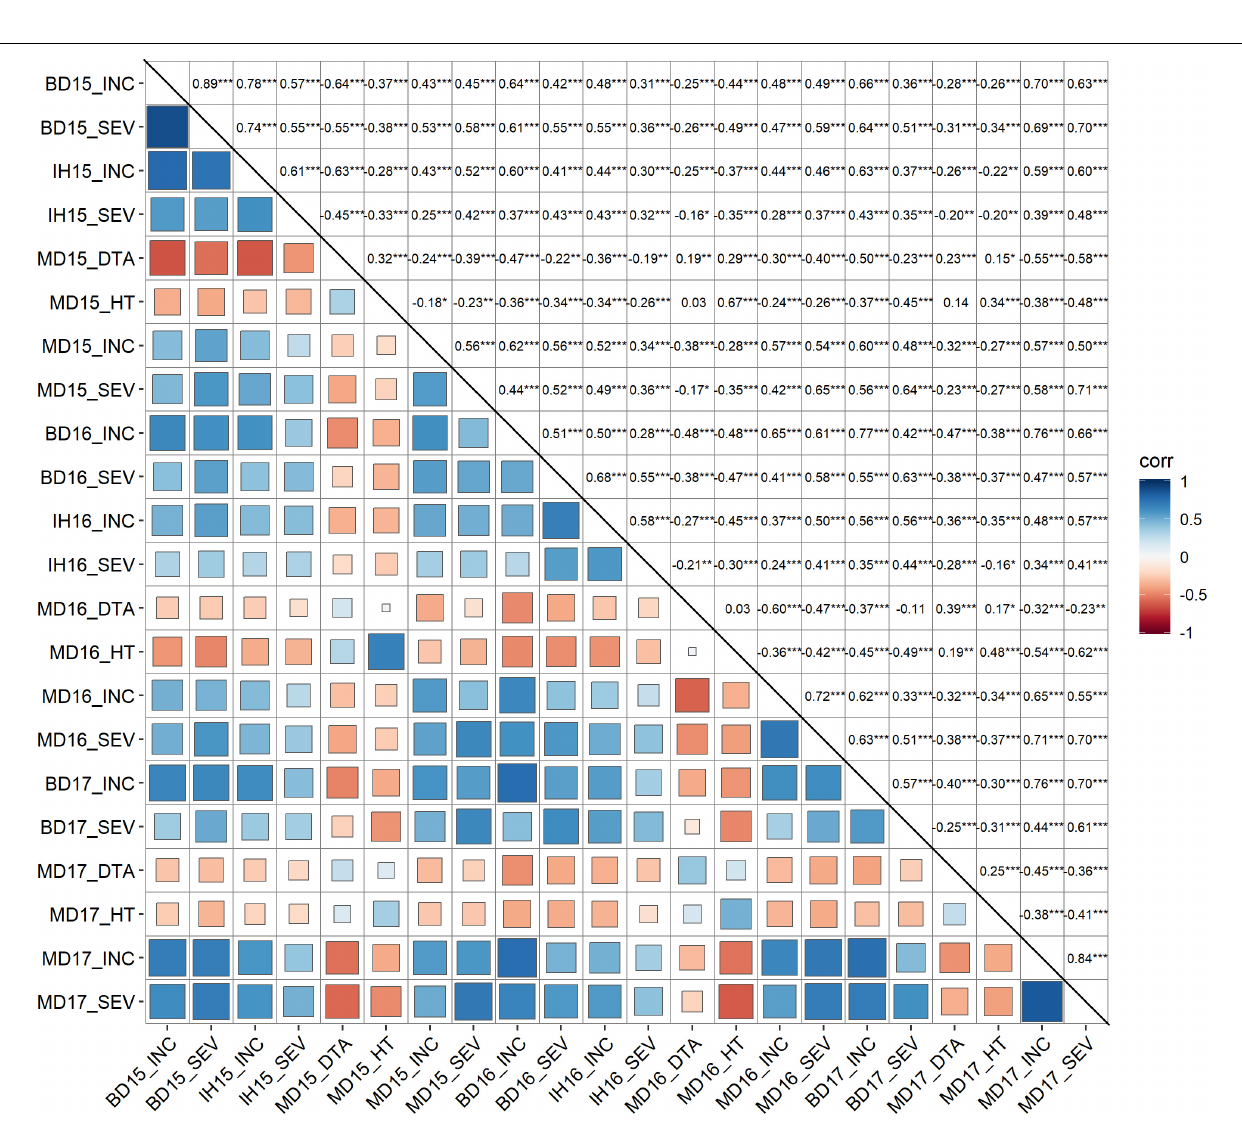
FIGURE 3 | Pearson correlation analysis of fusarium head blight resistance related traits. INC, Incidence (%), FHB incidence, percentage of spikes showing symptoms; SEV, severity (%), percentage of spike area infected; HT, plant height (cM); and DTA, day to anthesis. MD, Morden, MB; BD, Brandon, MB; IH, Indian Head, SK; 15, 16, and 17, field trials in year 2015, 2016 and 2017. Correlation coefficients were shown in upper triangle. Levels of significance claimed at * P < 0.05; ** p < 0.005, *** p <